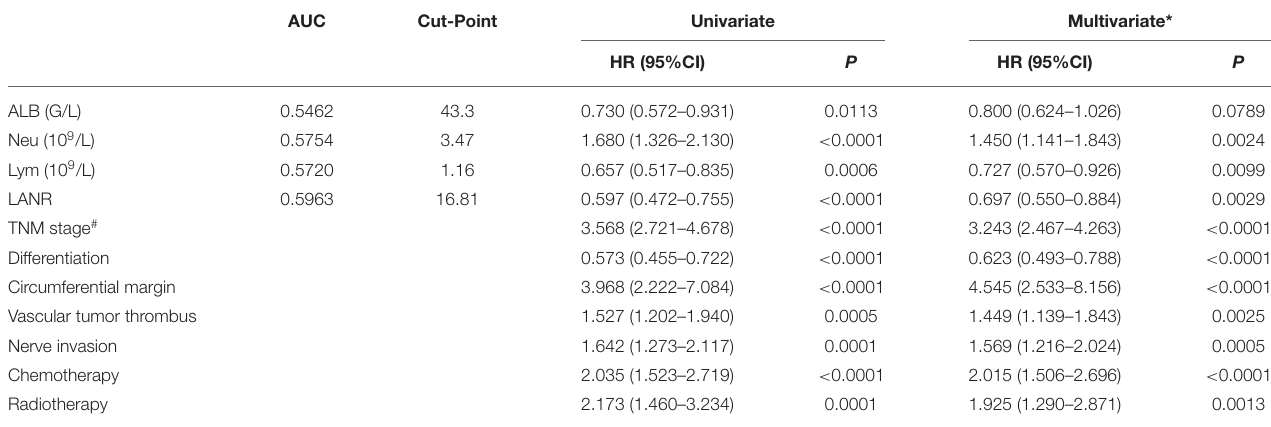
TABLE 3 | Univariate and multivariate cox regression analysis of progression-free survival in patients with colorectal cancer. AUC Cut-Point Univariate